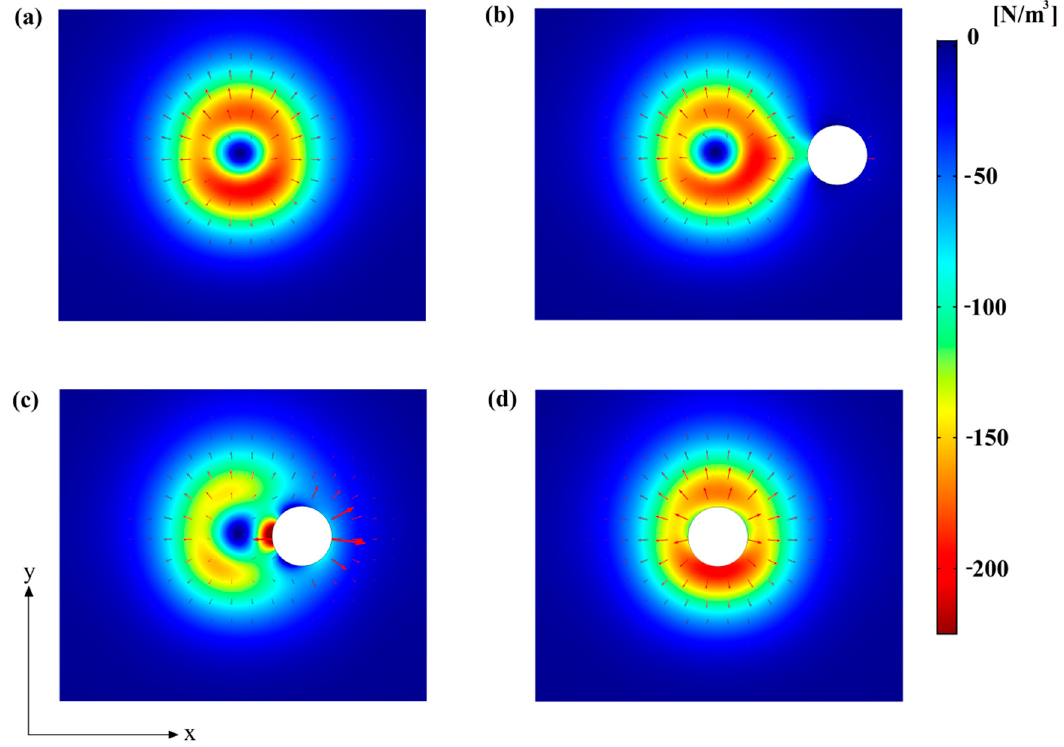
Figure 6. Lorentz force density distribution with the defect present at different positions ( a ) No defect; ( b ) x = − 4 mm; ( c ) x = − 2 mm; and ( d ) x = 0 mm. The color presents the z-component intensity where the arrow presents the direction and intensity in x - y plane.